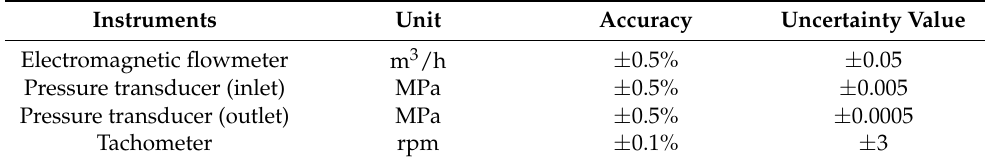
Table 4. Instruments of the test